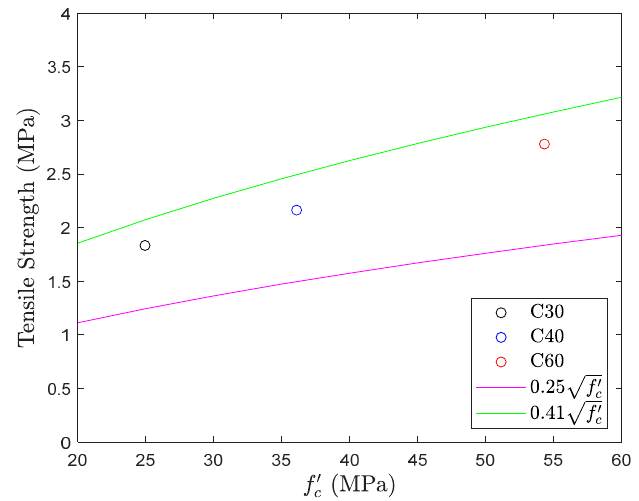
Figure 21. Tensile strength obtained from strut-and-tie beam test.